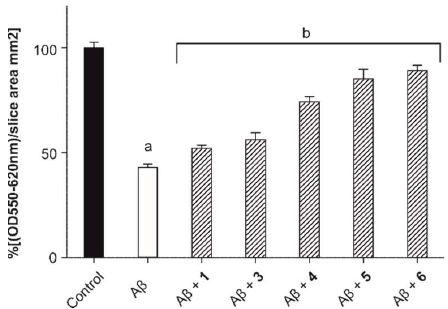
Figure 5. Results of the ex vivo tissue viability test after treatment with Aβ oligomers in 10 µM concentration alone (white column) and in the presence of compounds 1 , 3 – 6 in a 1:1 molar ratio. Untreated slices were used as a control (black column). Data are presented as means ± SD, N = 4.